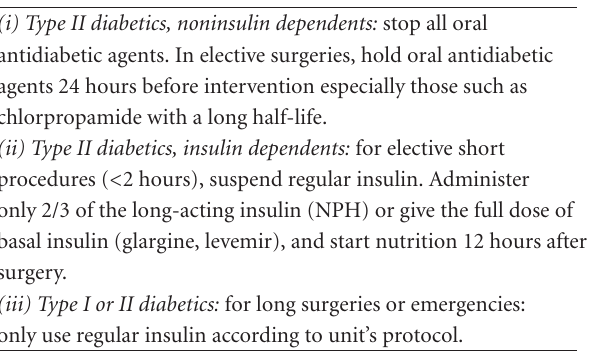
Table 2: Preoperative evaluation of the neurosurgical